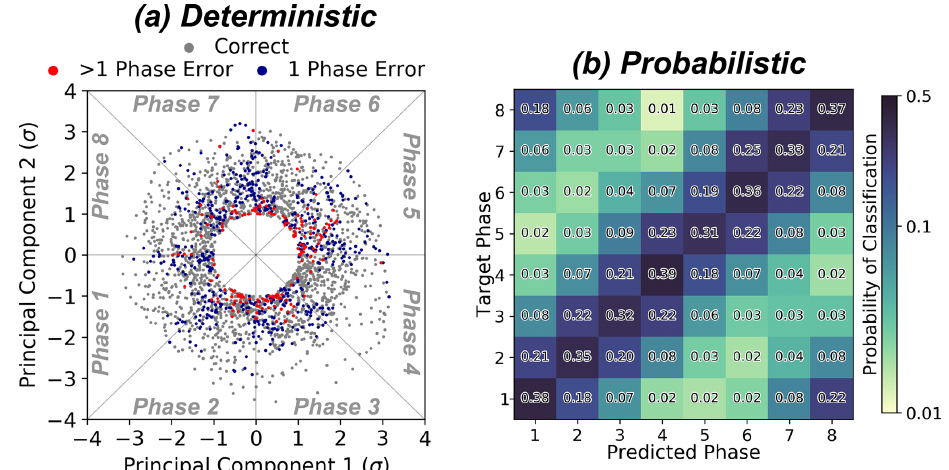
Figure 4. Example visualizations of the accuracy of the neural networks, in this case for the neural network centered on 10 January. (a) De- terministic accuracy, where samples that are correctly classified are colored gray, those assigned to phase 1 before or after the true phase are colored blue, and those assigned to phase 2 or more different from the true phase are colored red. (b) Probabilistic accuracy, where the average probabilities assigned to each sample within the validation dataset are shown for each target phase. The probabilities summed across each row sum to 1.